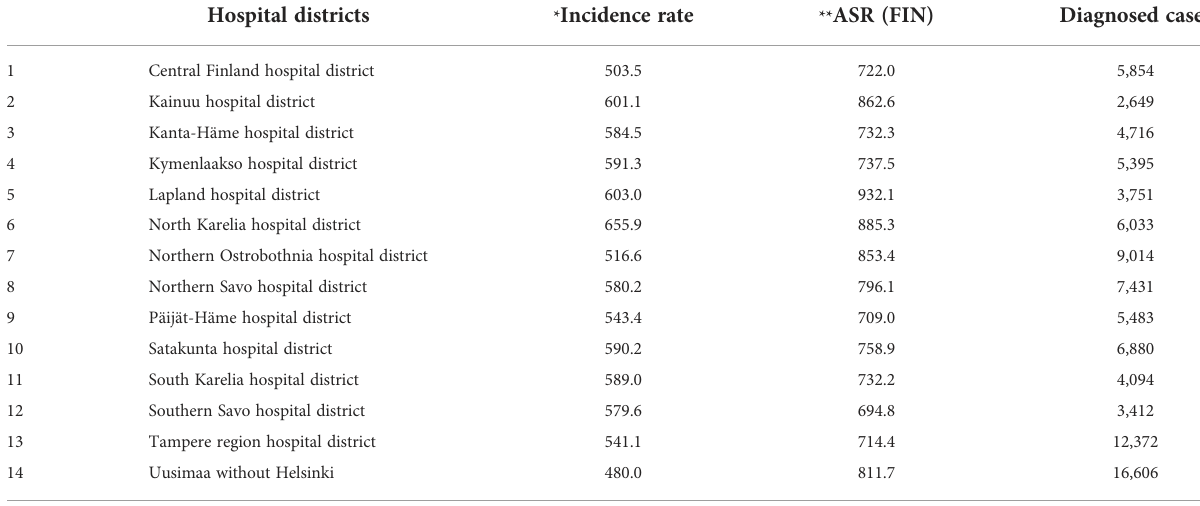
TABLE 2 The incidence rate and total number of diagnosed lung cancer cases in Finland from 1955 to 2019, by hospital